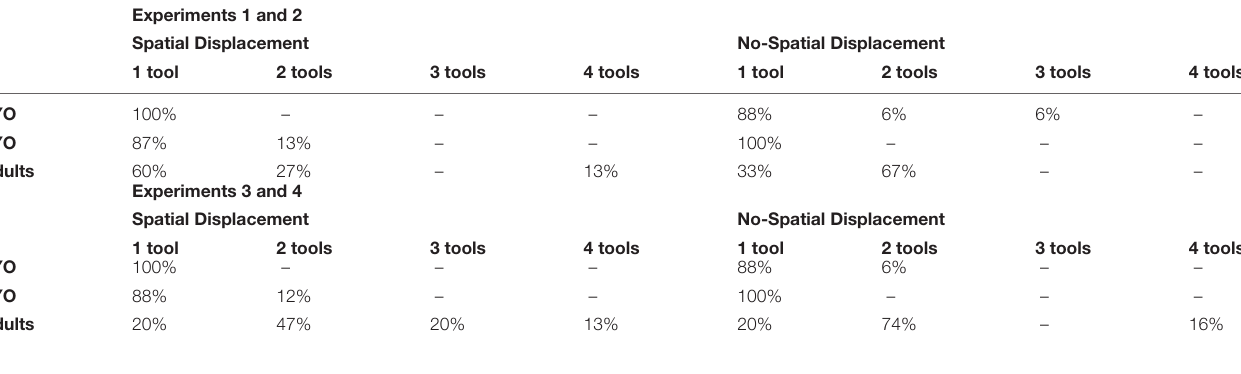
TABLE 1 | Percentage of children and adults selecting 1, 2, 3, or 4 tools in their first tool-choice opportunity in both the No-spatial displacement condition and the Spatial Displacement